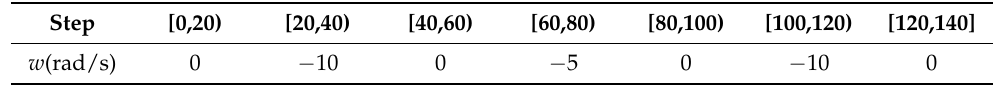
Table 7. Maneuvering process in